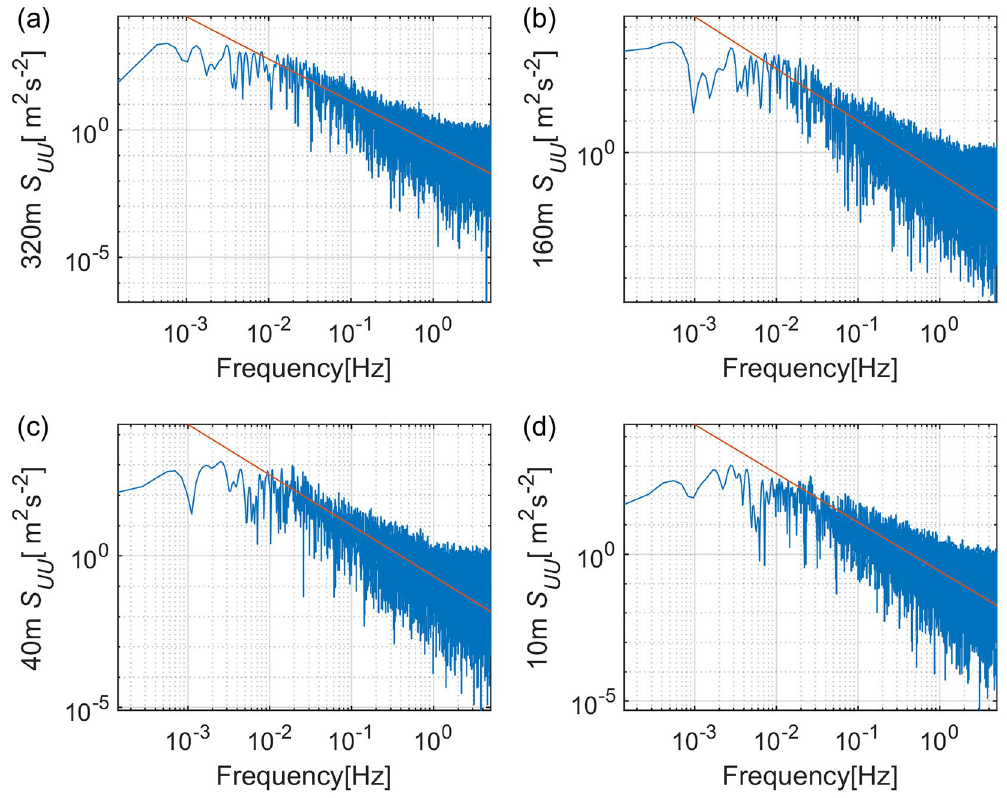
Figure 3. Examples of along-wind velocity spectra at ( a ) 320 m, ( b ) 160 m, ( c ) 40 m and ( d ) 10 m height. The red lines with a slope − 5/3 indicate the inertial subrange. The record time is 2018-09-16